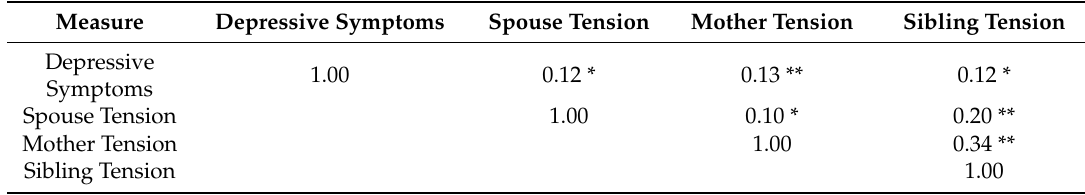
Table 2. Bivariate Correlations among Key Study Variables.